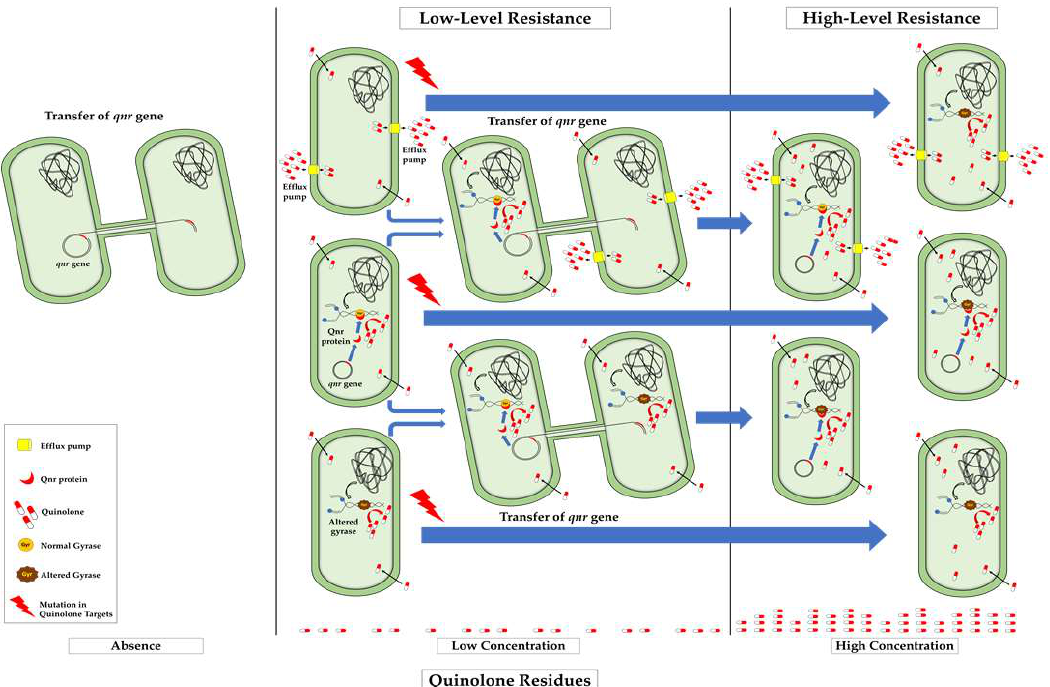
Figure 2. Main events that influence the prevalence and dissemination of qnr genes in the aquatic environment and their potential relationships with high-level quinolone resistance. Furthermore, qnr genes associated with integrons have frequently been reported [87,157,158,270,271], thus favoring their spread by horizontal transfer. In addition, given the ability of integrons to capture more antimicrobial resistance encoding genes, it is common to find qnr genes accompanied by other genes in the same integron, such as aadA and bla genes, which encode for resistance to aminoglycosides and β-lactams, respectively [23,60]. This situation would make the scenario of antibiotic resistance even more complex.